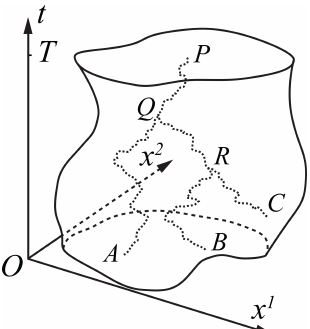
Figure 1. Schematic illustration of process splittings in a t ⊗ R 2 space. A stochastic process travels backward in time from point P and splits into two at point Q , where its projected functional value is found to be sufficiently large (see text for exact meaning). One child process splits again at point R , where its projected functional value is found to be even larger. The independent child processes would eventually stop either in ¯ (cid:127) as at points A and B or on ∂ 1 (cid:127) as at point C